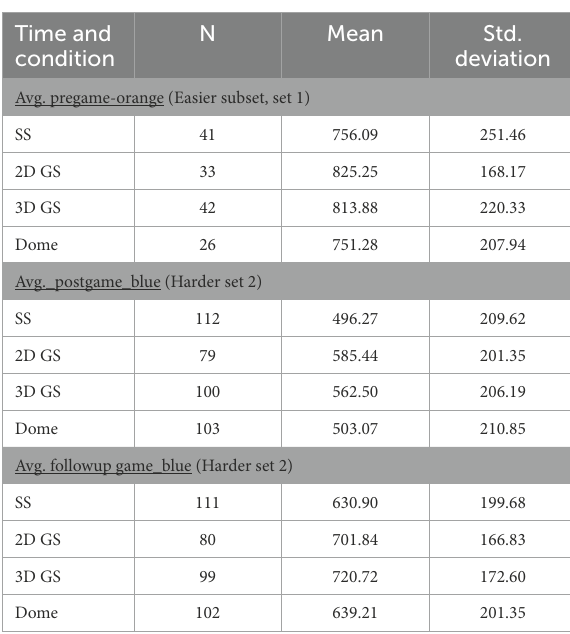
TABLE 3D Descriptives of gameplay.